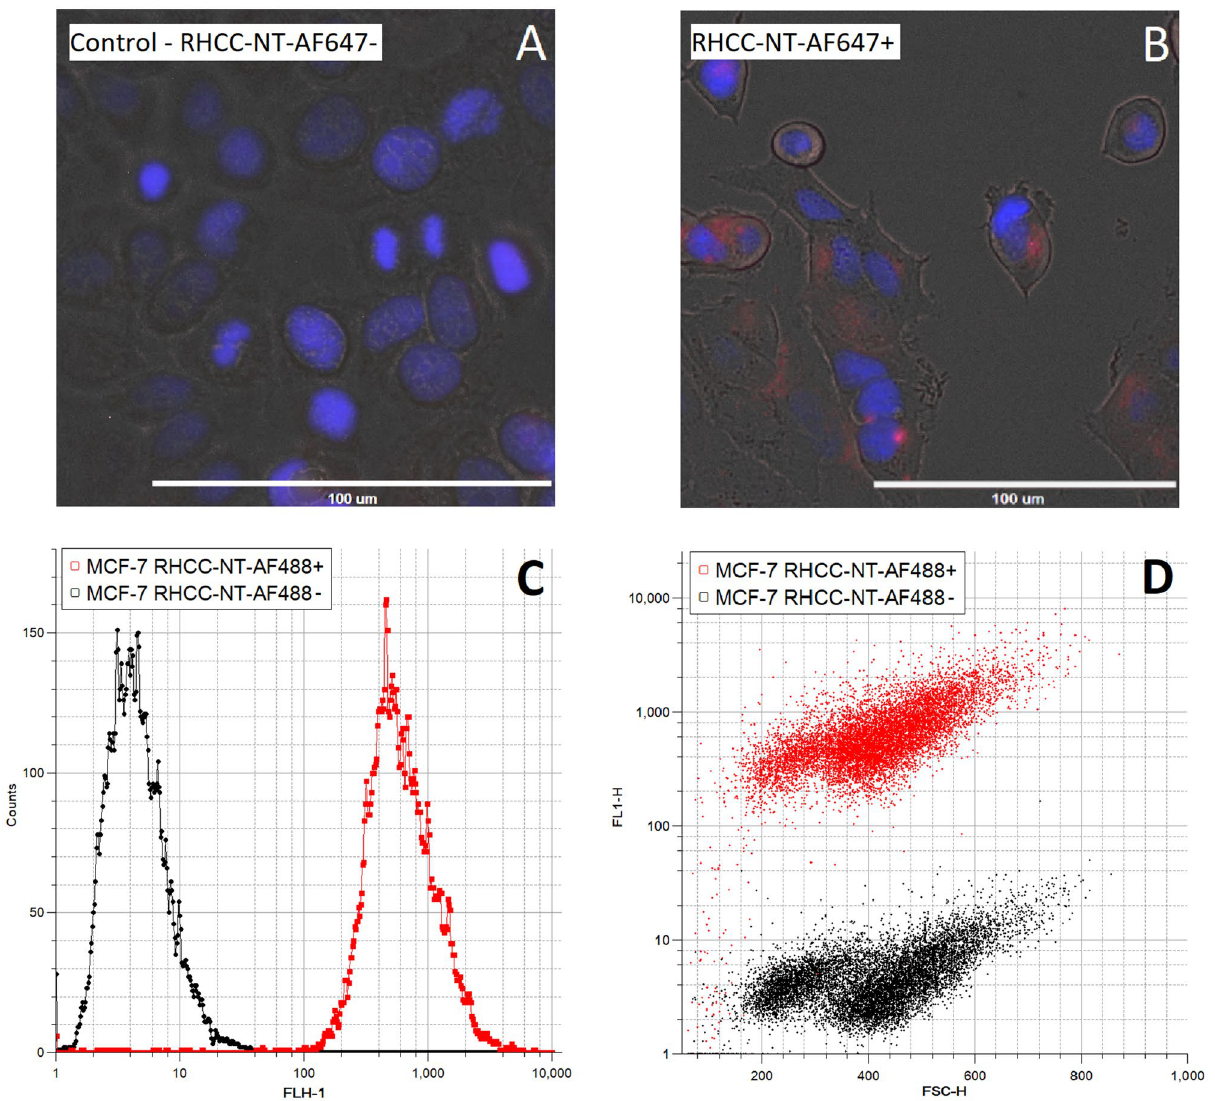
Figure 3. Nanotube cell-internalization assays using fluorescently labeled RHCC-NT show the accumulation of RHCC-NT inside of eukaryotic cells. ( A ) MCF-7 cells and ( B ) MCF-7 cells incubated with RHCC-NT-AF647 for 16 h were washed and imaged using multiple fluorescent and bright-field filters. Cell nuclei were stained with NucBlue™. ( C ) Fluorescent shift in flow cytometry of MCF-7 cells incubated with RHCC-NT-AF488 (red) compared against the negative control (black). ( D ) Forward scattering profile against the fluorescent shift of MCF-7 cells incubated with and without